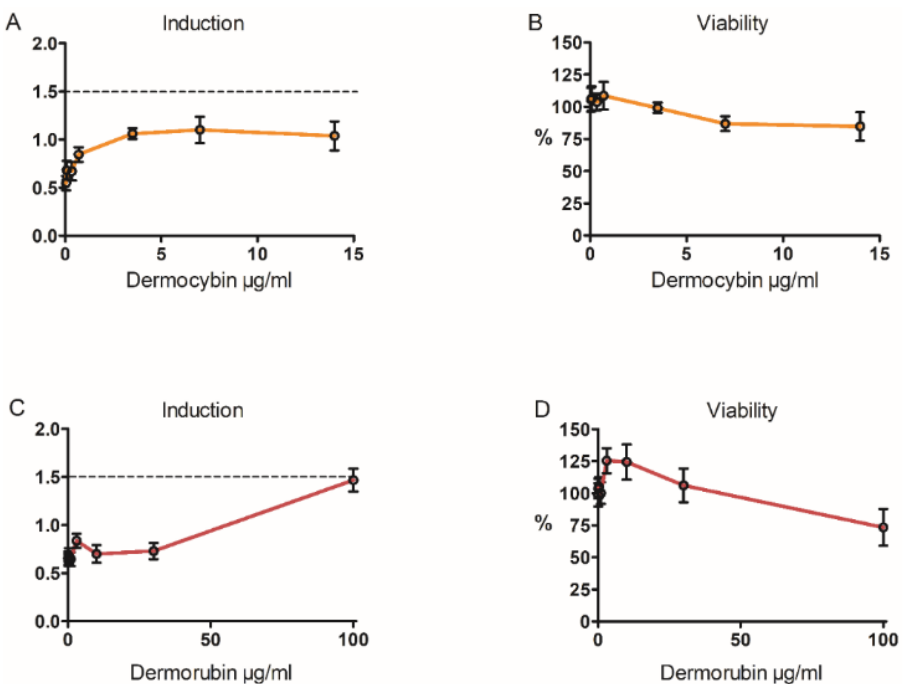
Figure 5. Results of the skin sensitization assay. In figures ( A ) and ( C ), the reporter gene induction compared to control is shown. A 1.5-fold increase is defined as the limit of induction (dotted line). In figures ( B ) and ( D ), keratinocyte viability compared to control is presented, n = 4.